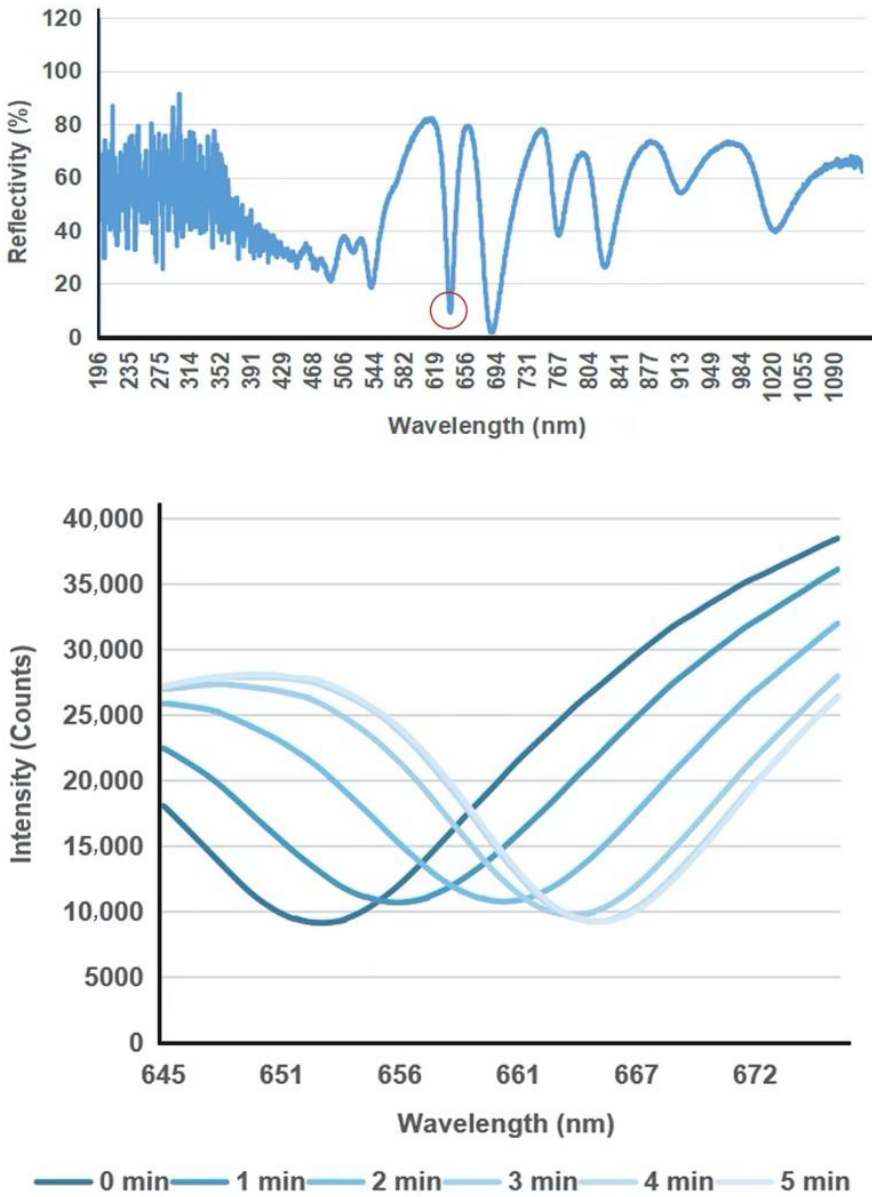
Figure 5. The biosensor’s response for detecting SARS-CoV-2 N protein (10 ng/ µ L). Above: characteristic valley of the reflection spectrum used for tracking the spectral shift is circled in red. Below: real-time shift of the characteristic valley as the N protein of SARS-CoV-2 is binding with the specific antibody.